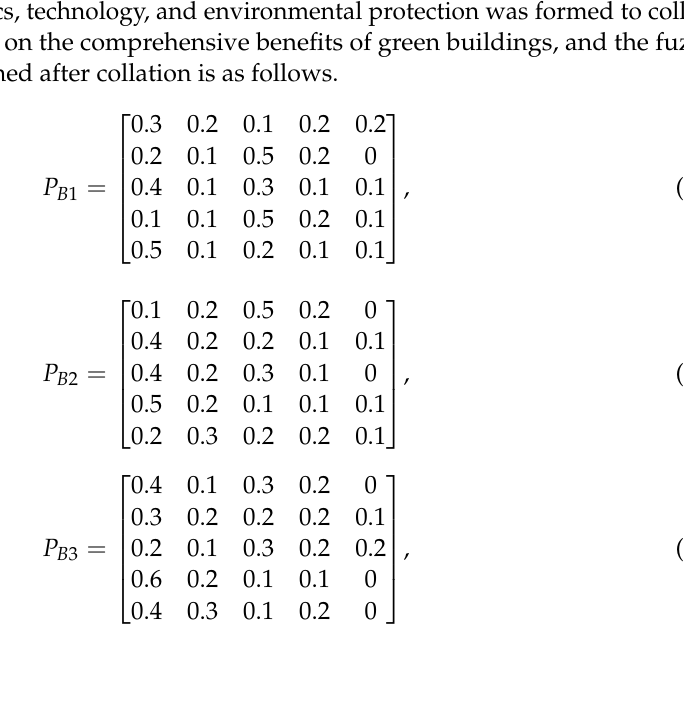
Figure 3. The weighting diagram of scheme layer indicators. ( a ) Weights of C11-C15. ( b ) Weights of C21-U25. ( c ) Weights of C31-U35. ( d ) Weights of U41-U44.